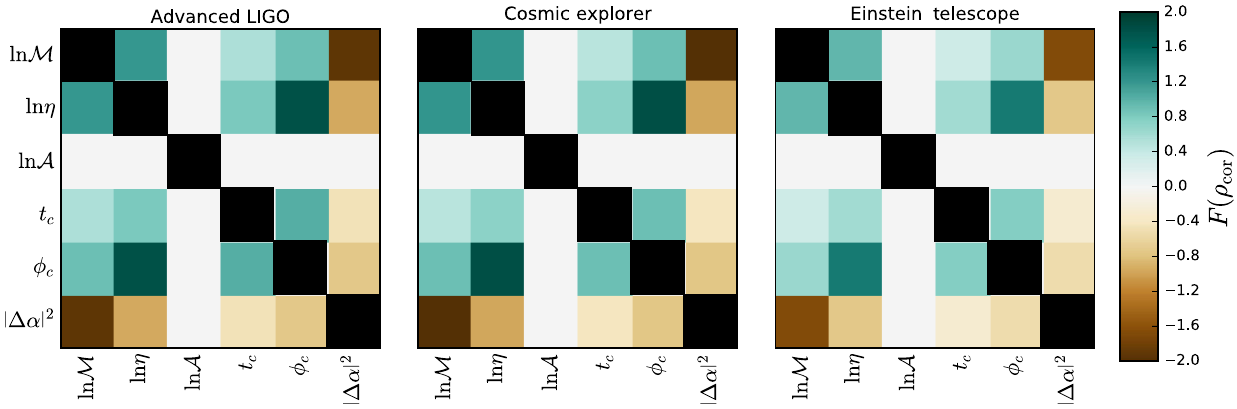
FIG. 8. The correlations between six parameters, obtained from the inverse Fisher matrix in the matched-filter analysis for a BNS with rest-frame masses ð 1 . 25 M ⊙ ; 1 . 63 M ⊙ Þ . Here, F ð ρ such that it counts 9 ’ s in the limit of large correlations [e.g., F ð 0 . 99 Þ ≃ þ 2 , F ð − 0 . 9 Þ ≃ − 1 , and F ð 0 Þ ¼ 0 ]. On the diagonal, F ð ρ diverges and is plotted in